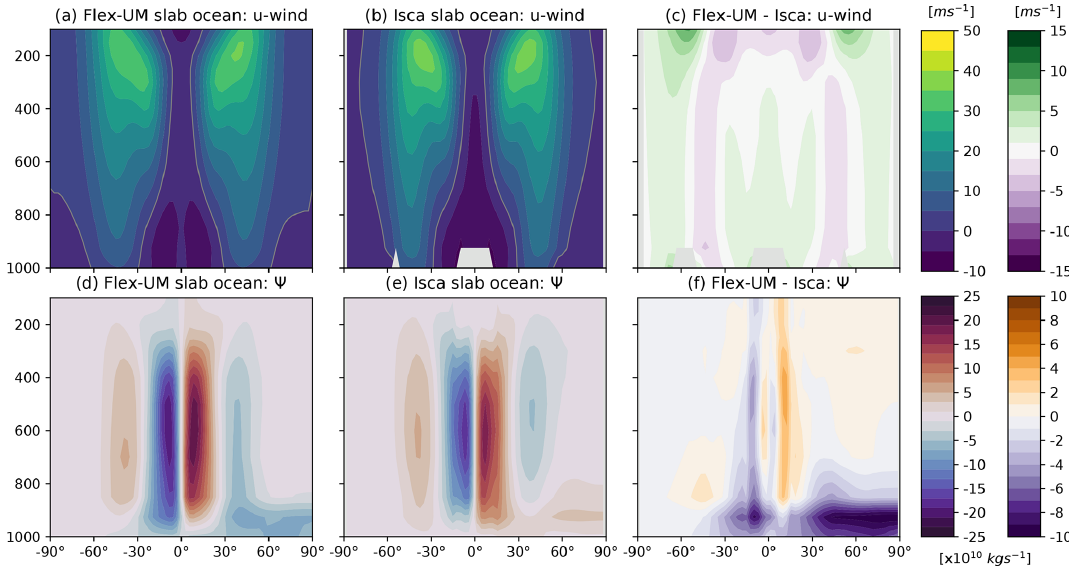
Figure 4. As in Fig. 3 but for zonal-mean zonal wind ( u in ms − 1 , a, b, c ) and mass stream function ( ψ in × 10 10 kgs − 1 , d, e, f ).